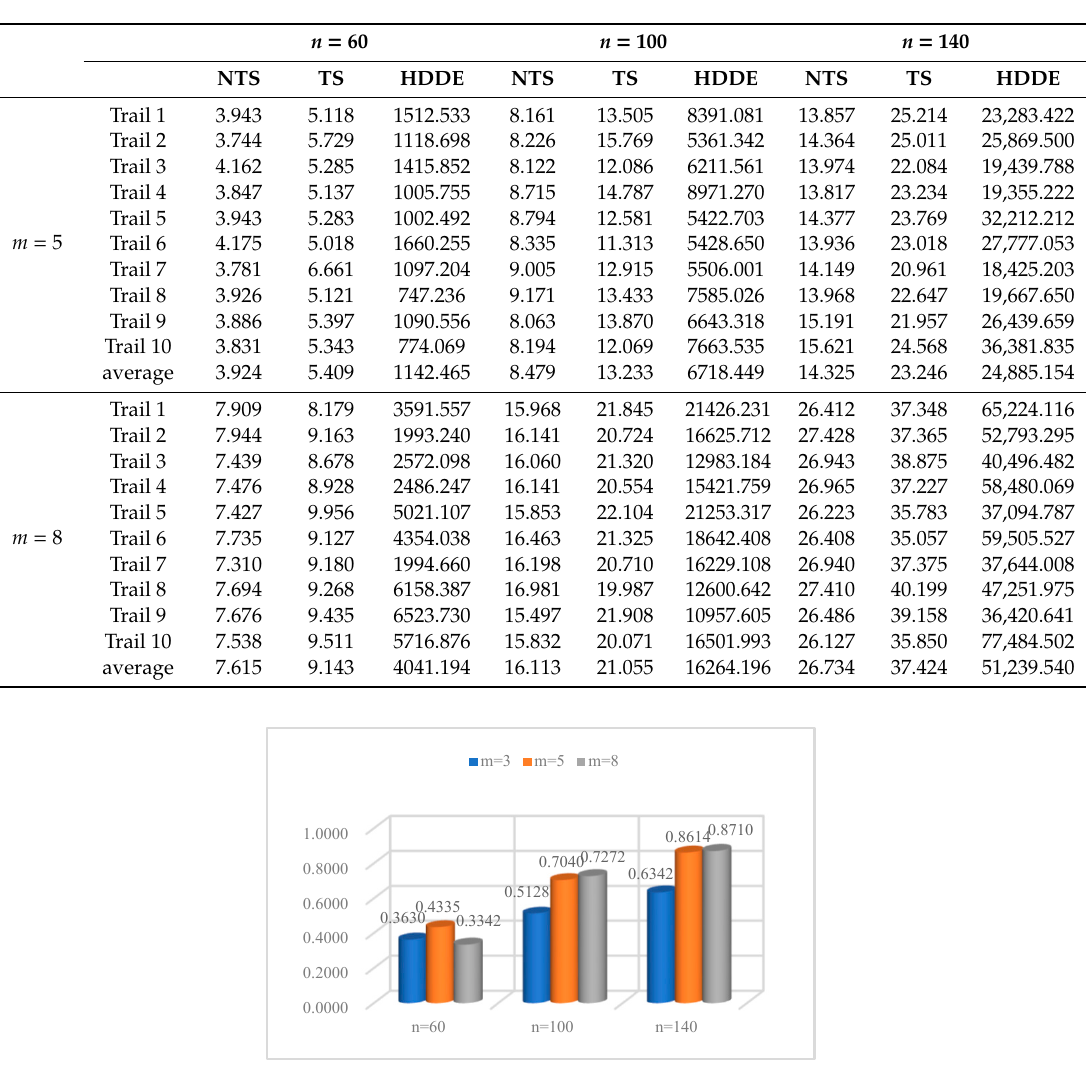
Figure 10. The average GAP concerning nine combinations of n = 60, 100, and 140 and m = 3, 5, and 8.